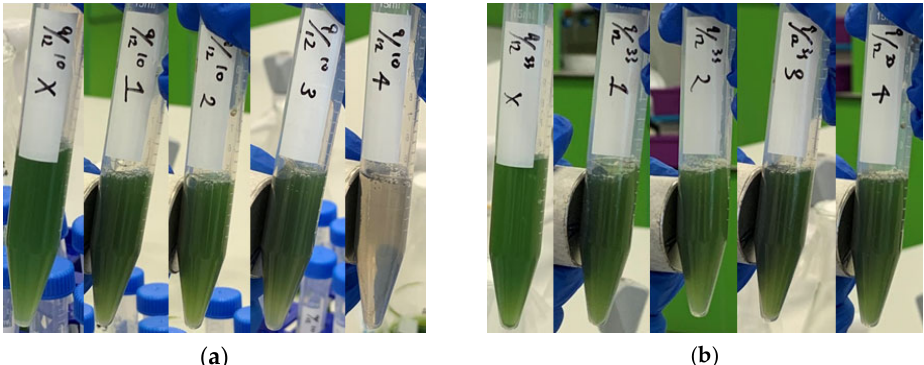
Figure 4. Comparison of different synthesized magnetic nanoparticles and salinity effects on mag ‐ netic separation (45 s) for Tetraselmis sp.: ( a ) 10‰ salinity medium, ( b ) 33 ‰ salinity medium (tubes separation (45 s) for Tetraselmis sp.: ( a ) 10‰ salinity medium, ( b ) 33‰ salinity medium (tubes from left from left to right: control (5 mL cell culture at start), bare Fe 3 O 4 , NH 2 ‐ Fe 3 O 4 , citrate ‐ 80C ‐ Fe 3 O 4 , to right: control (5 mL cell culture at start), bare Fe 3 O 4 , NH 2 -Fe 3 O 4 , citrate-80C-Fe 3 O 4 , PDDA-Fe 3 O 4 PDDA ‐ Fe 3 O 4 ).